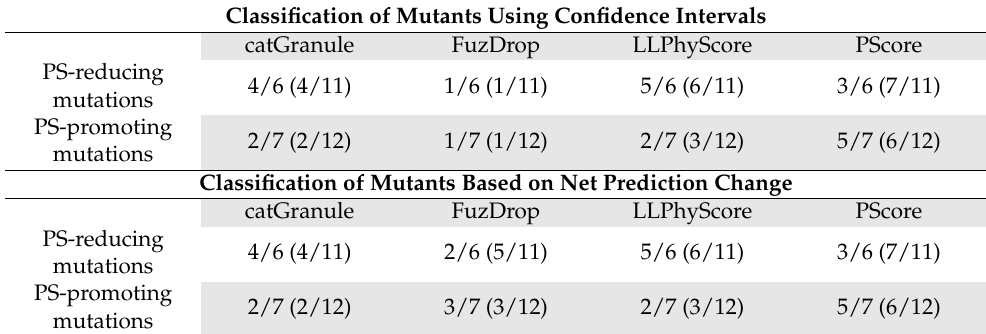
Table 1. Table with classification results. Classification of Mutants Using Confidence Intervals catGranule FuzDrop LLPhyScore PScore PS-reducing